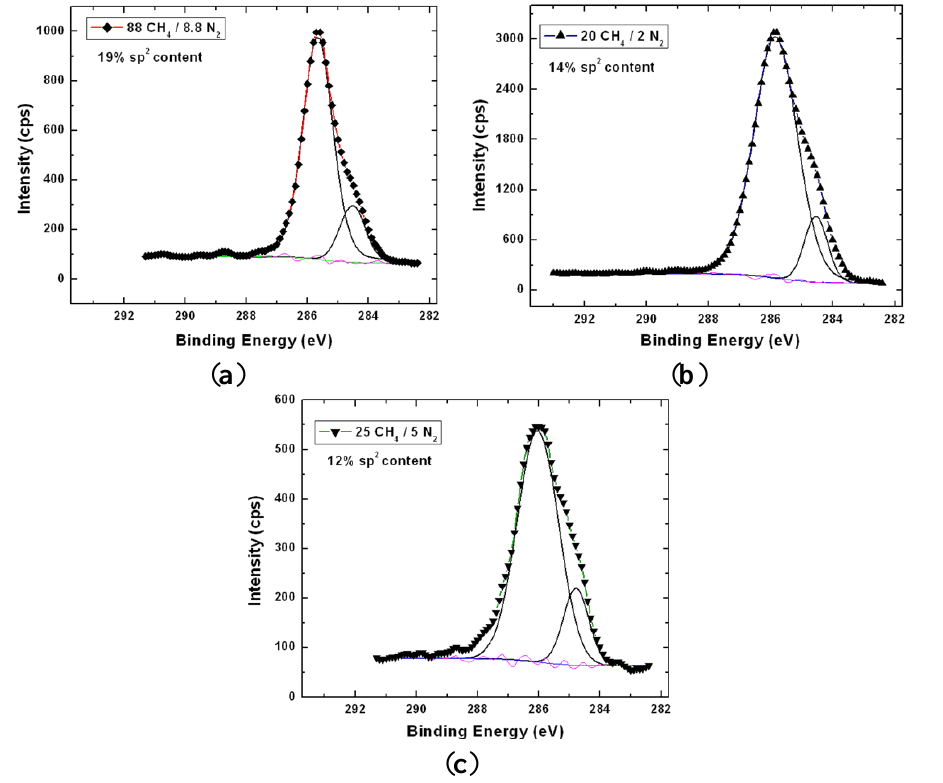
Figure 5. XPS high resolution spectra (C1s) of NSD films grown on silicon with different gaseous chemistries showing different sp 2 contents. Low methane chemistry resulted in NSD films with less sp 2 content.